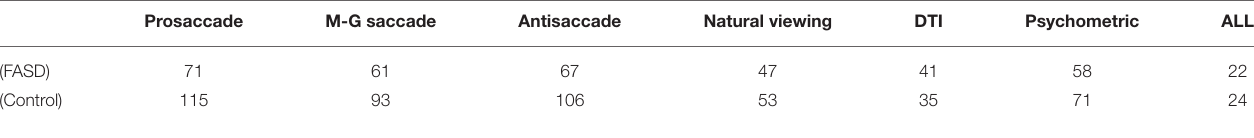
TABLE 2 | Participants for different assessments.